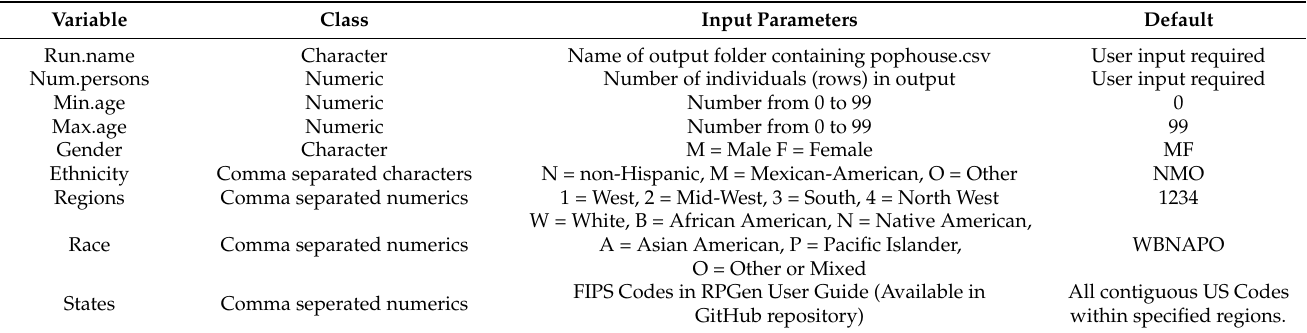
Table 1. User inputs to RPGen.